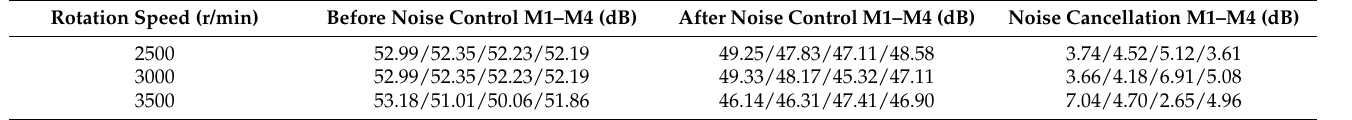
Table 4. 4-channel fractional-order ANC algorithm vehicle engine noise control data